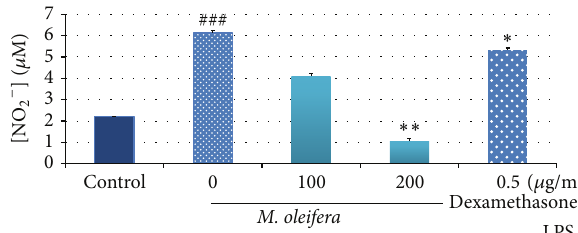
Figure 3: Effects of 80% hydroethanolic M. oleifera bioactive flower extract on NO production by LPS-induced RAW 264.7 macrophages. A density of 1 × 10 6 cells/well of macrophages in the presence or absence of LPS were seeded in 6-well plate and treated with indicated concentrations of flower extract and dexamethasone for 24h. The supernatants were collected and investigated by Griess assay. The data are presented as mean ± SD of three independent experiments. Control; basal level of nitrite released without LPS induction. ### 𝑝 < 0.001 : LPS-treated group versus control; ∗∗ 𝑝 < 0.01 and ∗ 𝑝 < 0.05 : treated group significantly different from LPS- treated